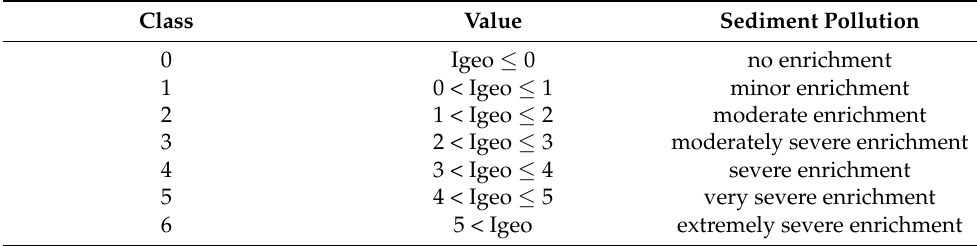
Table 1. Geoaccumulation Index (Igeo) classification.